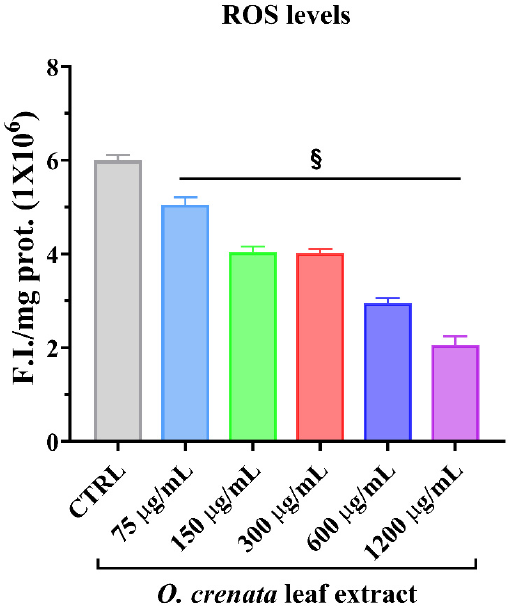
Figure 4. Intracellular oxidants in MCF-7 cells untreated and treated for 24 h with different concen- trations (75–1200 µg/mL) of O. crenata leaf extract. Values are the mean ± SD of four experiments in triplicate. § p < 0.0001 vs. untreated control (CTRL).